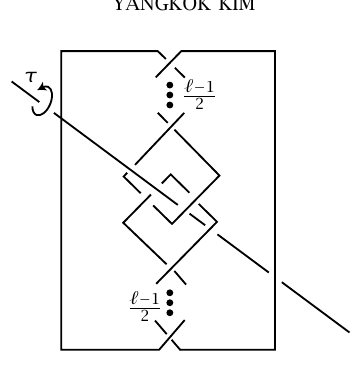
Figure 4.2 . The knot ((cid:2) + 1 ) 1 with τ .